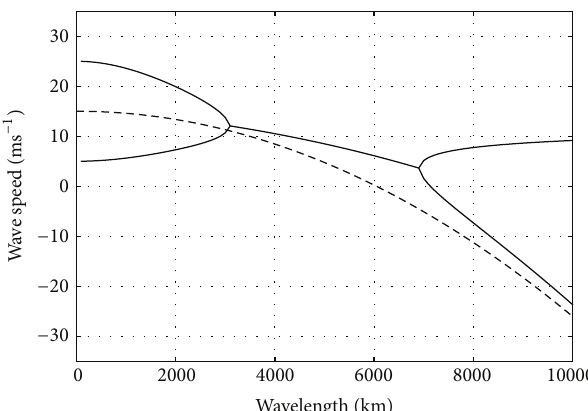
Figure 3: Phase velocity as a function of wavelength for baroclinic waves (solid line) and for Rossby waves (dashed line) for the case of = 7.5 m ⋅ s −1 , and 𝑢 = 15 m ⋅ s −1 . 𝜎 = 2 × 10 −6 m 2 ⋅ Pa −2 ⋅ s −2 , 𝑢 𝑇 𝑚